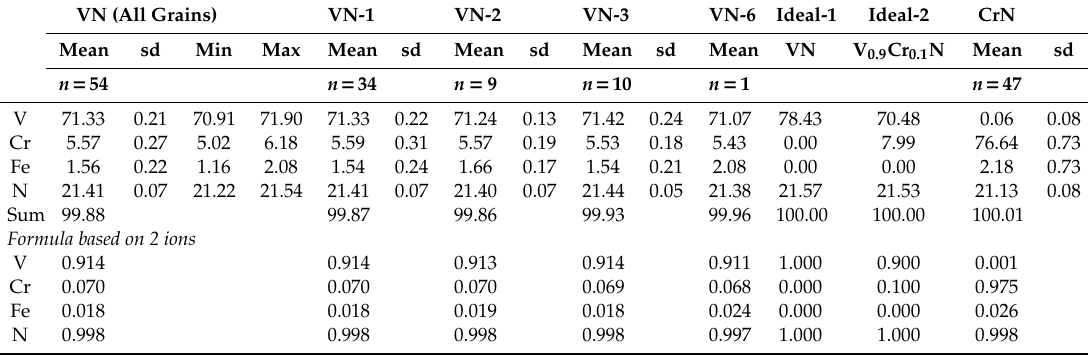
Table 2. Chemical composition (EDS, wt. %) of uakitite in comparison with ideal compositions and carlsbergite from the Uakit